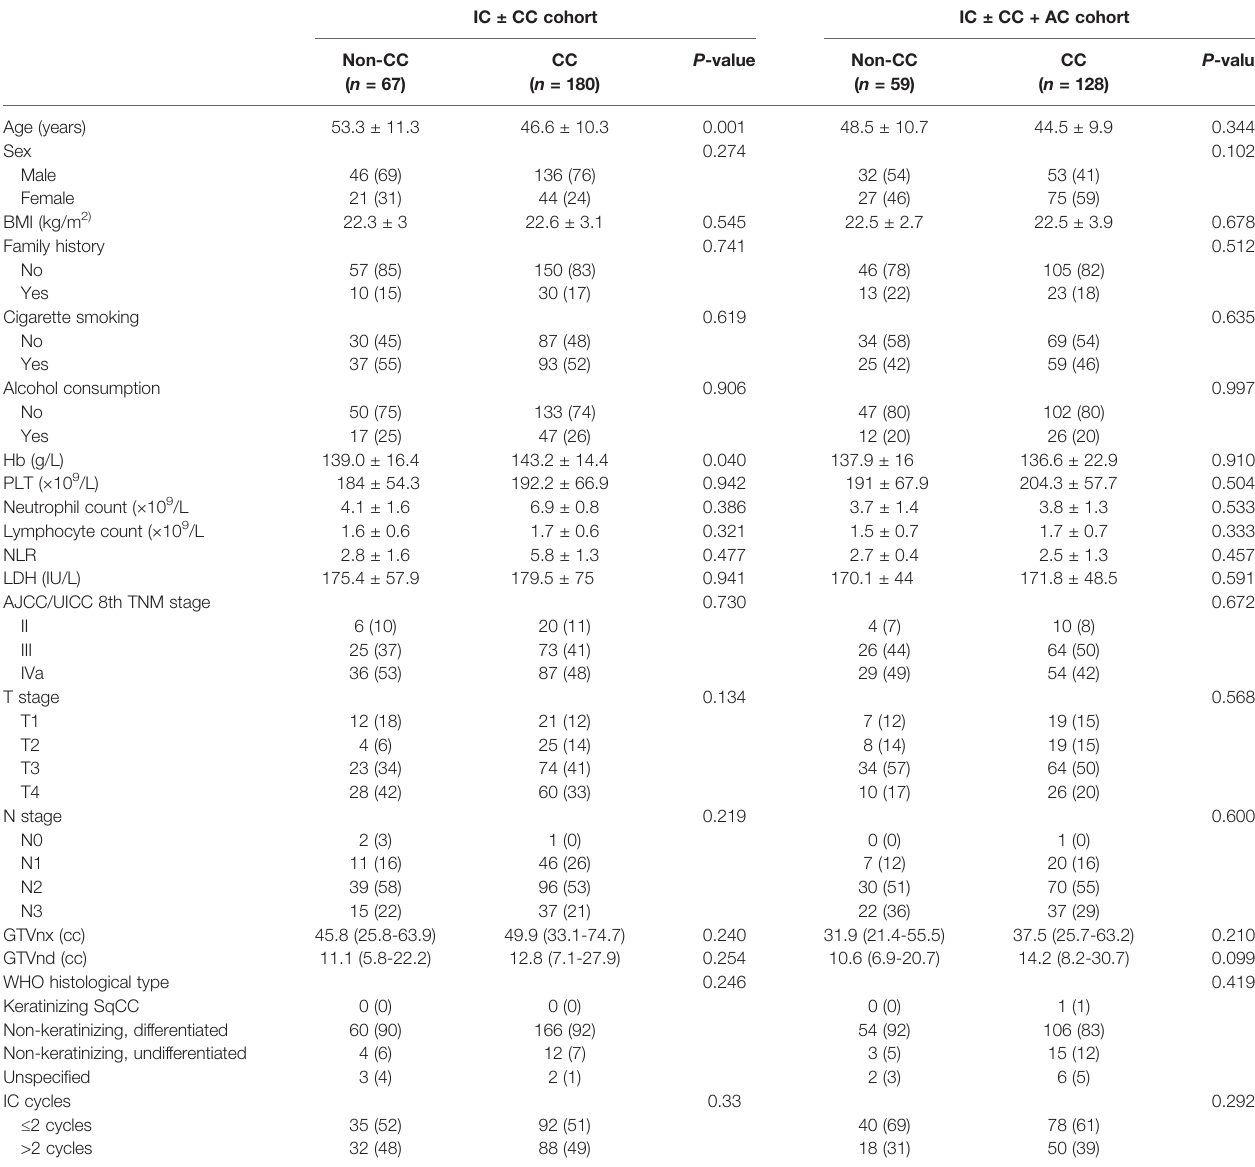
TABLE 1 | Characteristics of all patients ( n = 434) with nasopharyngeal carcinoma.